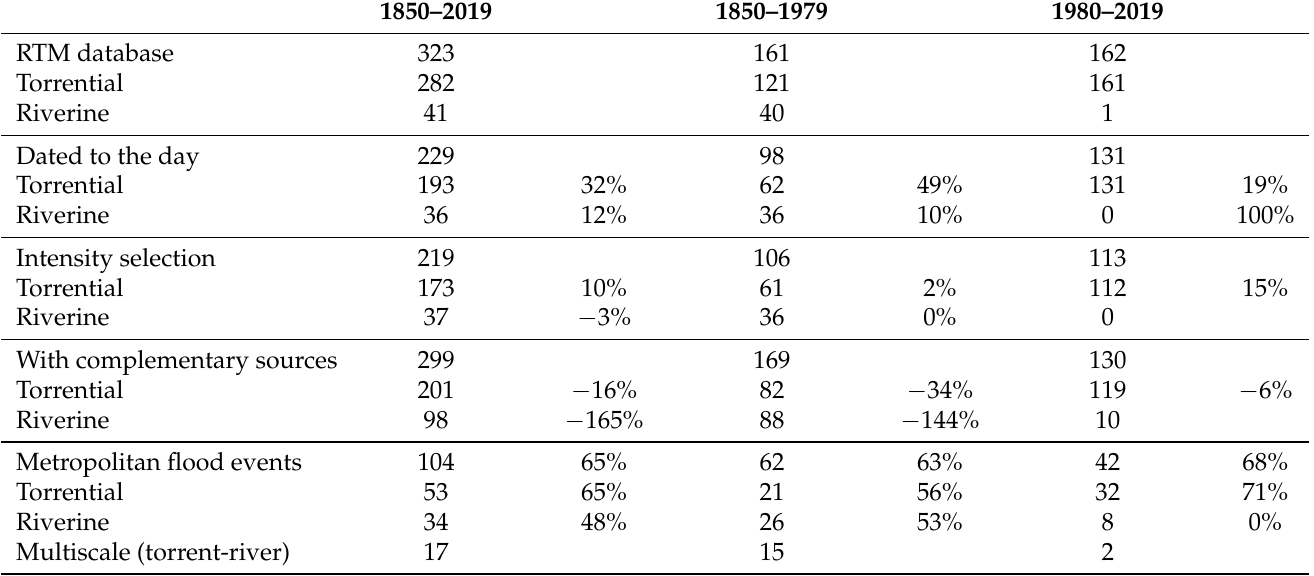
Table 5. The number of flood events over different periods of time (columns) and through different steps of selection (rows) to constitute the Metropolitan flood database. The five main sets of rows are (i) counts of RTM site events, (ii) number of RTM site events dated to the day, (iii) number of RTM site events selected according to a minimum intensity, (iv) counts of flood events aggregated from complementary sources such as the “Historisque” dataset, and (v) counts of Metropolitan flood events. For the RTM database (four first sets), we indicate the percentage of events discarded from one processing step to the next on the RTM database. For Metropolitan events (last set), the given percentages are the ratios between the number of site events and the number of Metropolitan events, taking multiscale events, torrential, and riverine, into